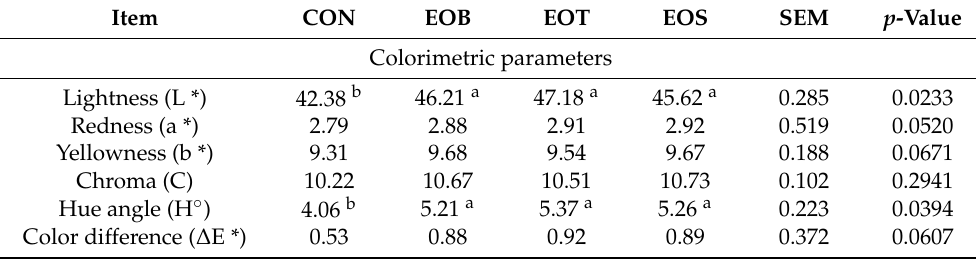
Table 3. Effect of dietary supplements on colorimetric and textural